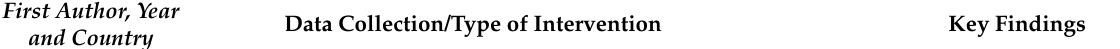
Table A2. Summary of studies regarding the effects of exercise at altitude during pregnancy (Part